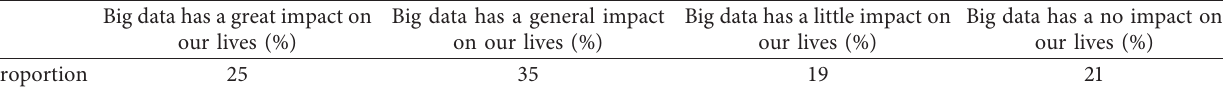
Table 5: Employees’ views on big